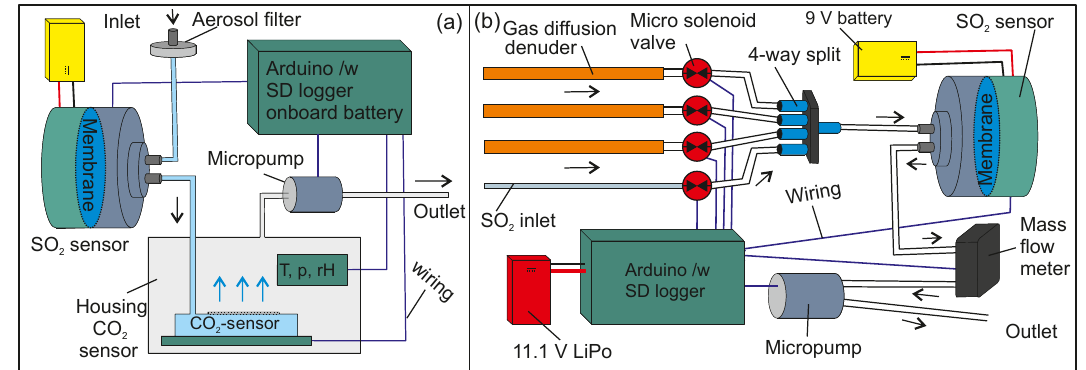
Figure 4. Schematics of the (a) Sunkist monitoring unit and the (b) black box gas sampling